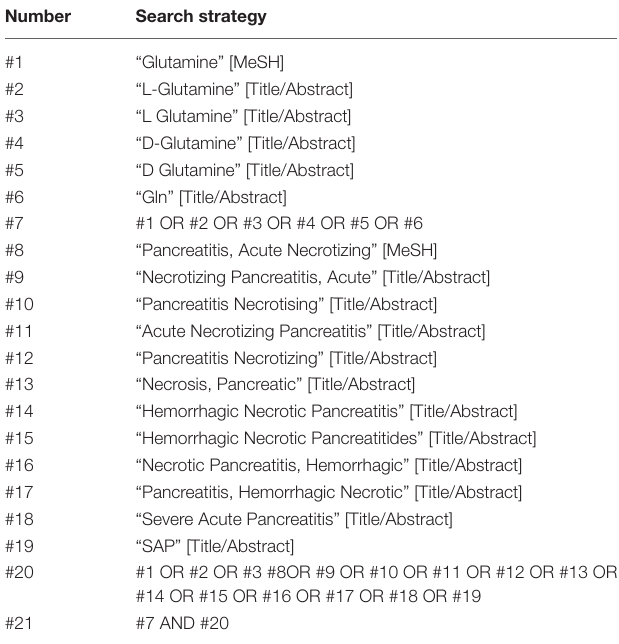
TABLE 1 | Retrieval strategy of